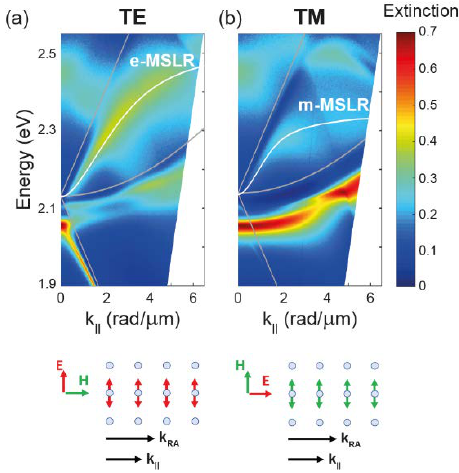
Fig. 1. Extinction of the MSLRs as function of the incident in- plane moment k || for TE (a) and TM (b) polarizations. The RAs are identified by the grey lines. The fit to the MSLRs of interest corresponds with the white solid curves. This corresponds with an electric MSLR (e-MSLR) and a magnetic MSLR (m-MSLR) for TE and TM polarizations, respectively. The character of the MSLR can be understood with the help of the bottom diagram that shows the preferential coupling between the excited dipoles for a given polarization of the incident light field.